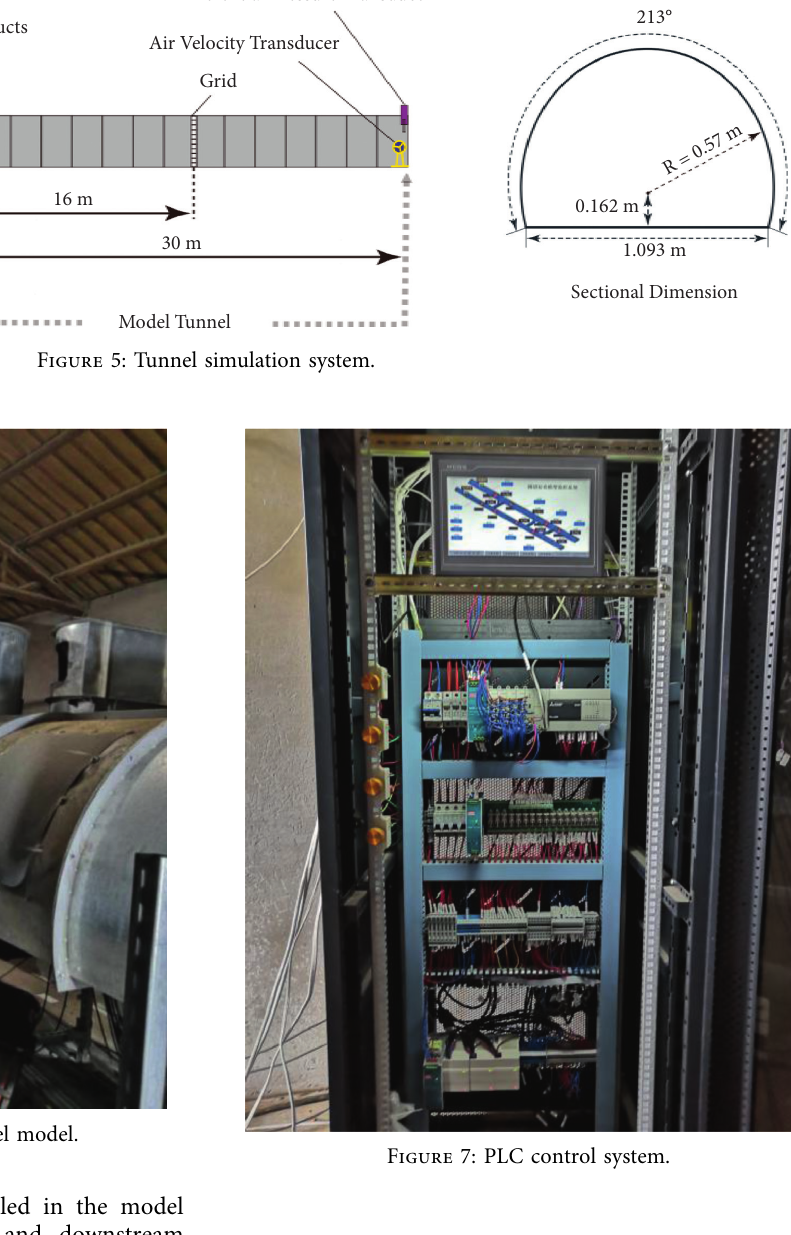
Table 1: The parameters of the grids used in the